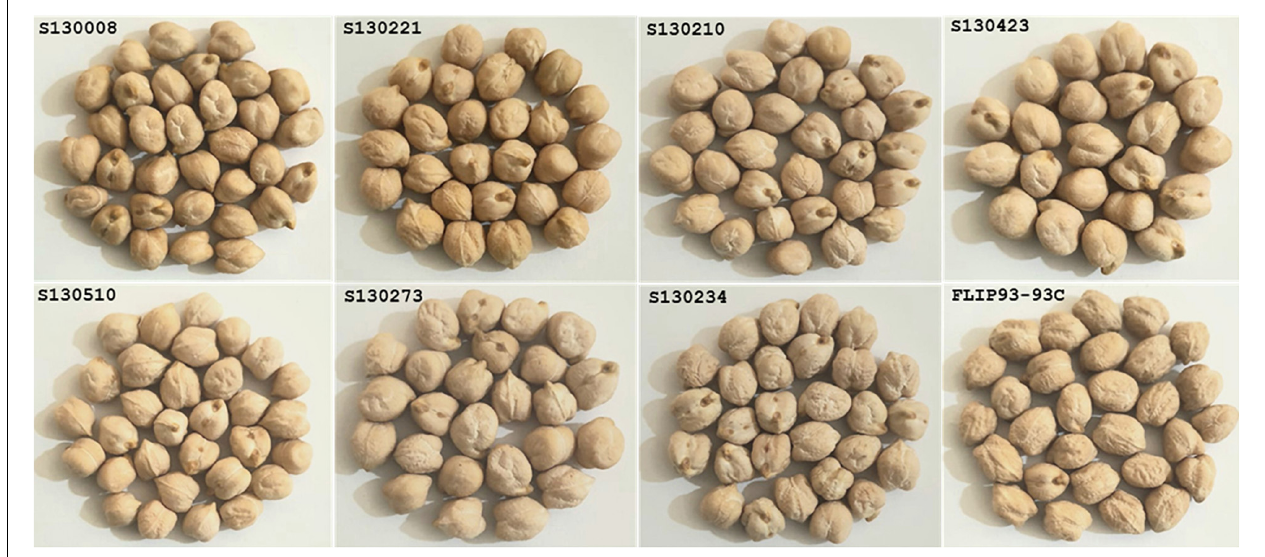
FIGURE 9 | Top two lines identified for early flowering (S130510 and S130008), high gain yield (FLIP93-93C), high protein content (S130221 and S130273), high Fe (S130234 and S130210), and high Zn (S130423)